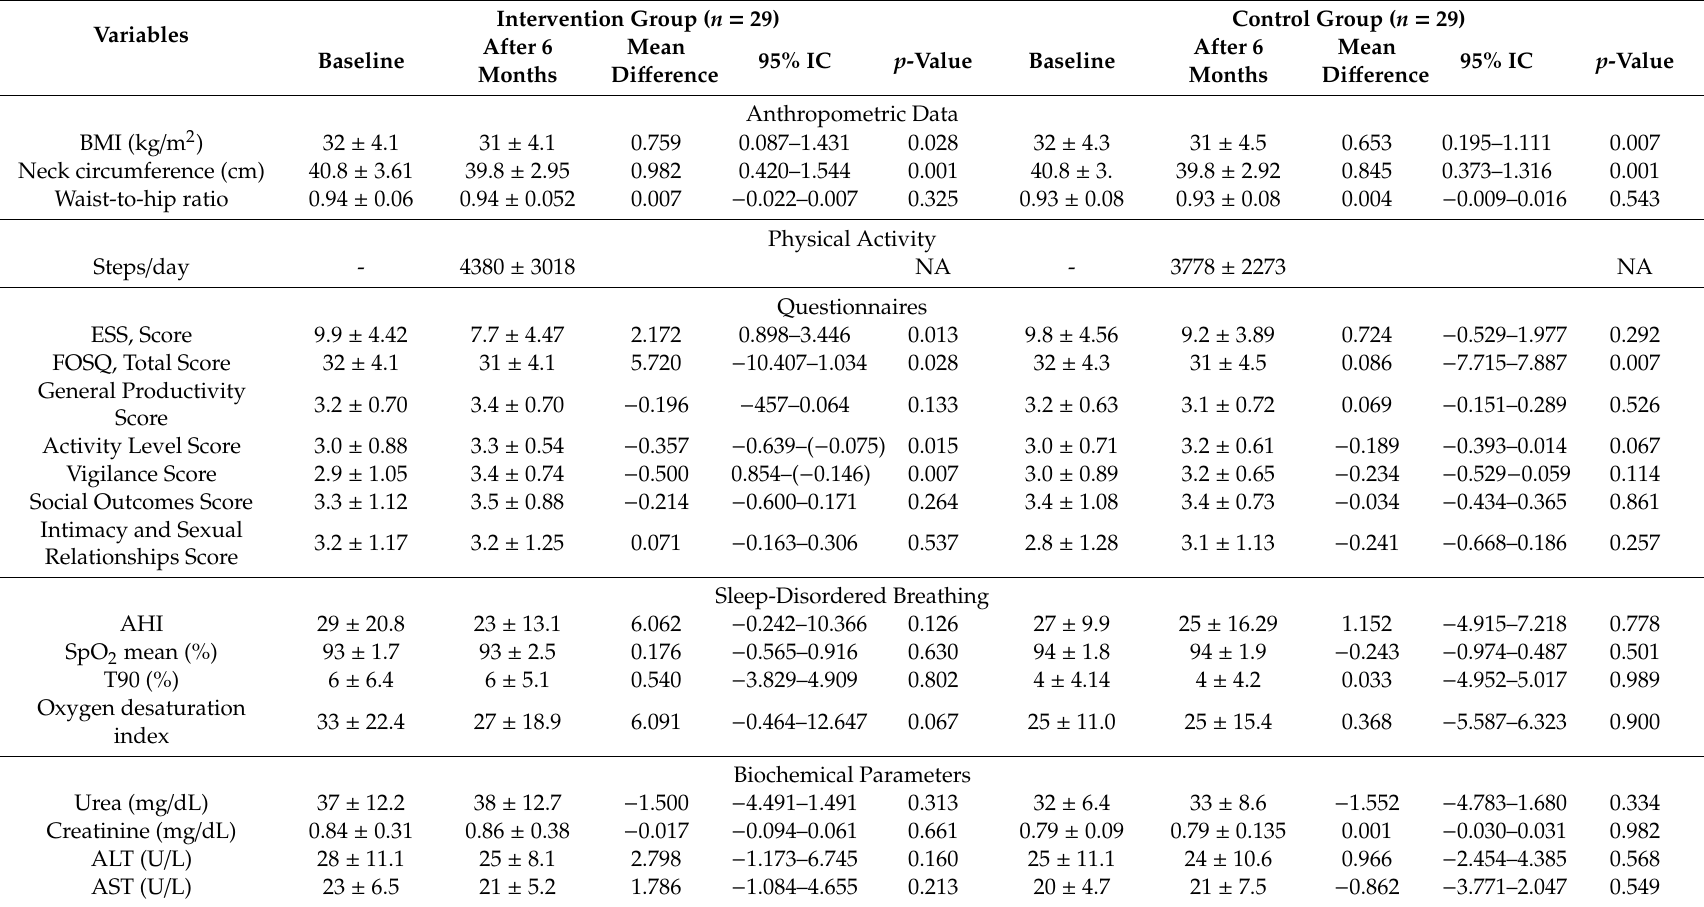
Table 2. Within-group changes in the intervention and control